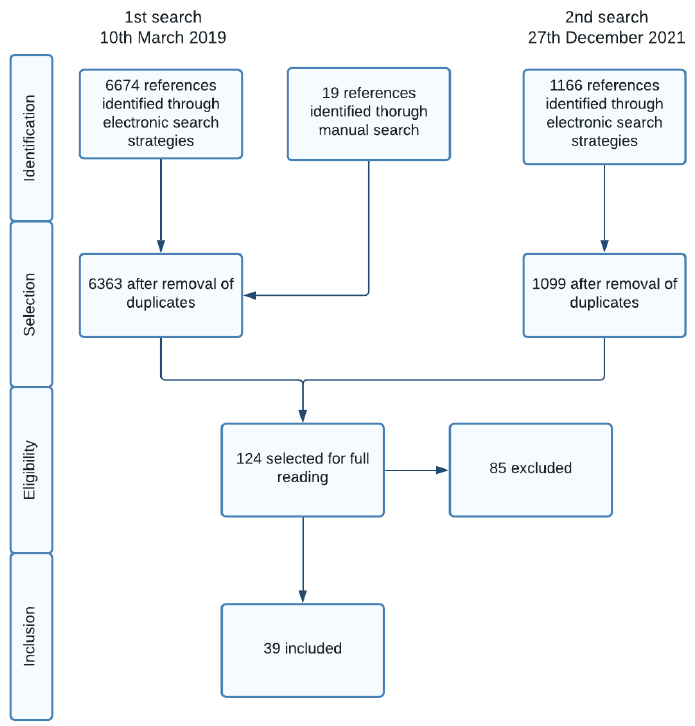
Figure 1. Study selection process.